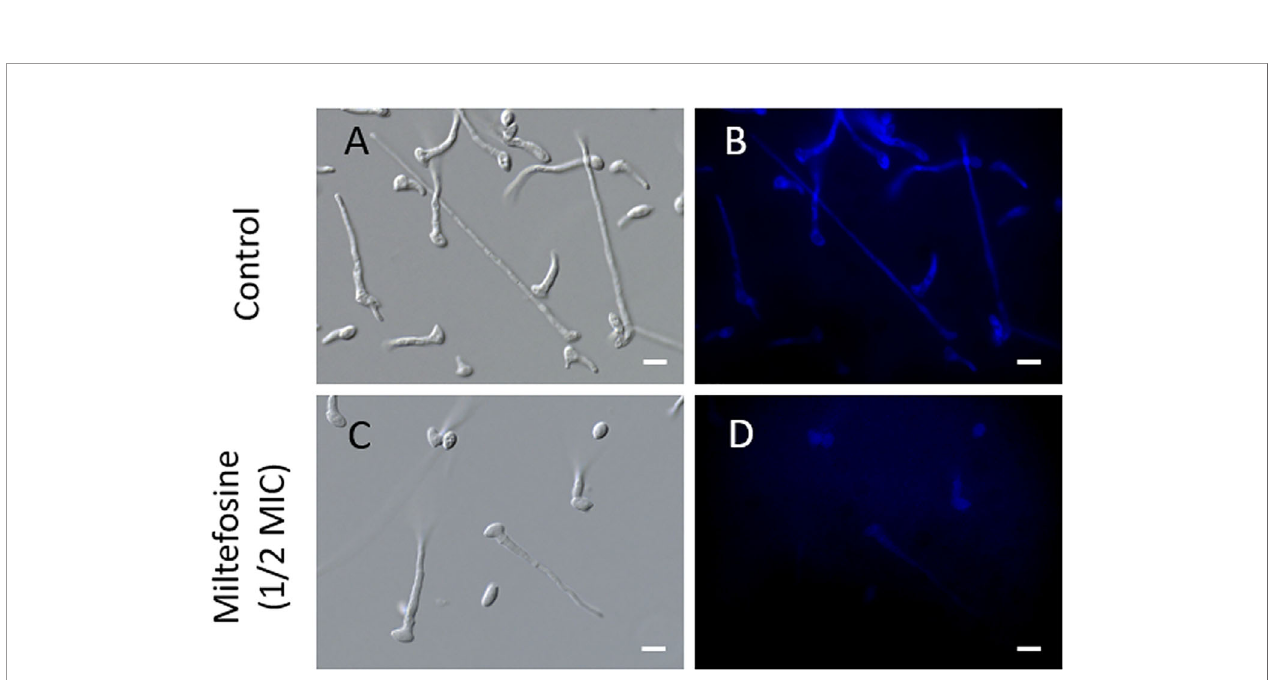
FIGURE 7 | The effect of miltefosine on Scedosporium aurantiacum lipid rafts. Filipin staining was used to evaluate the presence of sterol, which is a common marker for lipid raft regions in fungal membranes. (A, C) represent differential interferential contrast microscopy. (B, D) represent fl uorescence microscopy. The images show S. aurantiacum cells grown for 6 h at